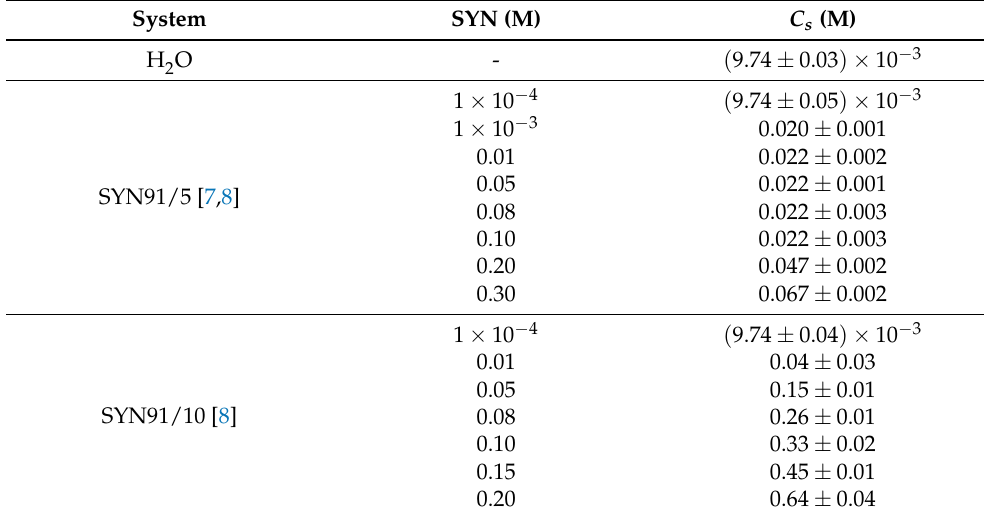
Table 1. [SYN91/5] and [SYN91/10] tested and the related C s values.